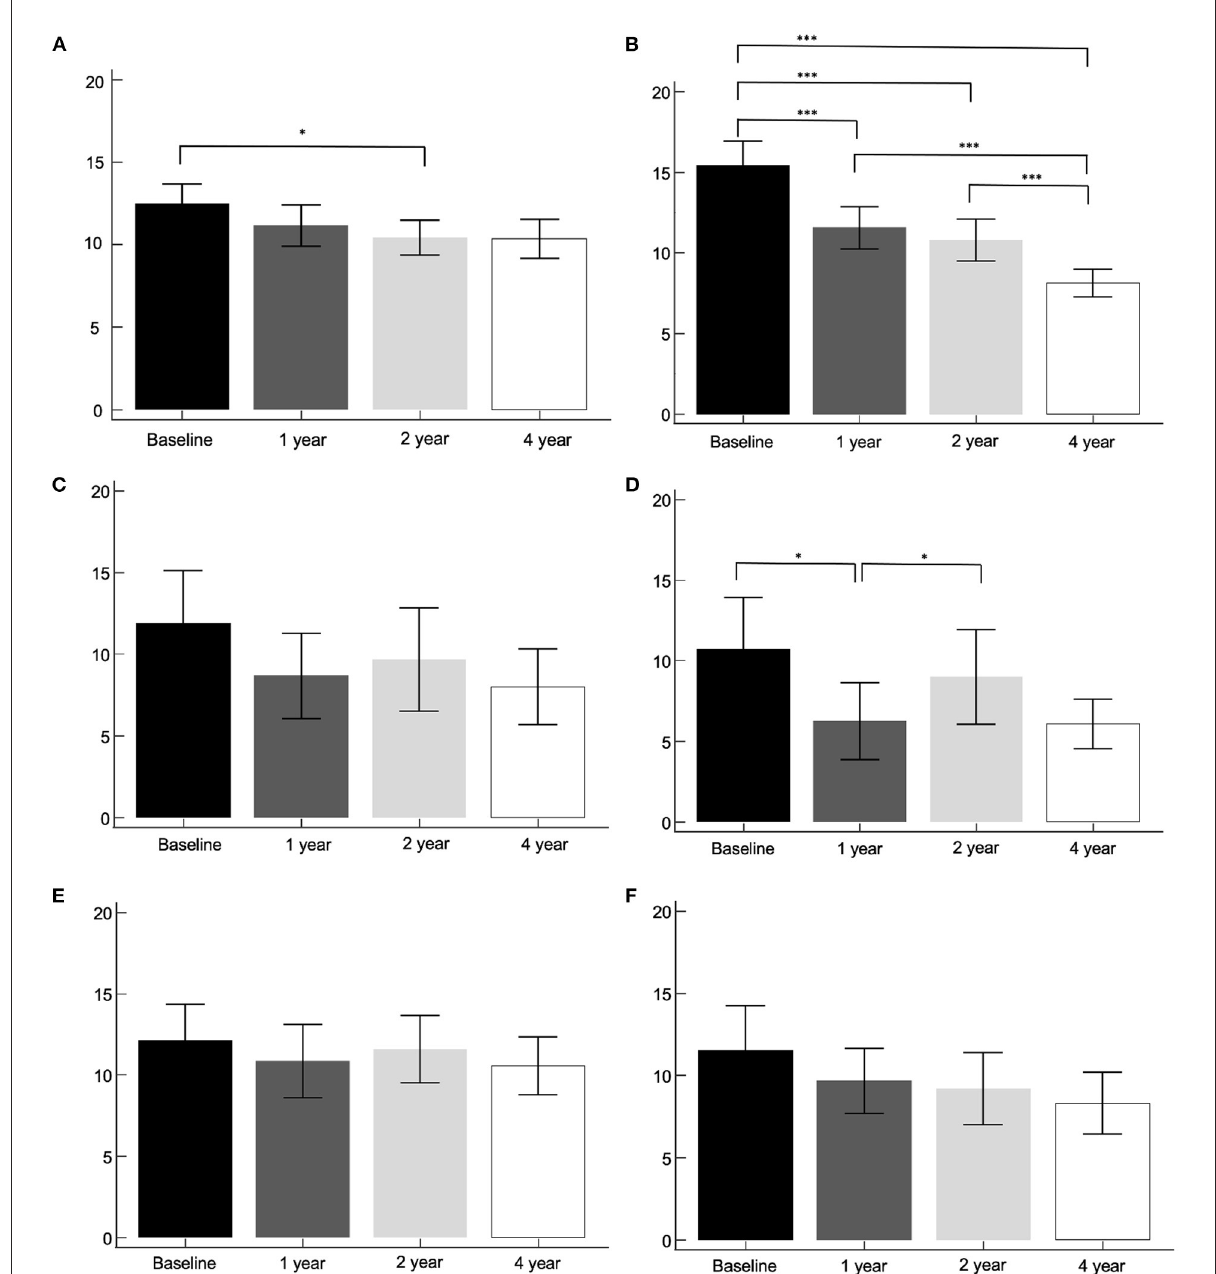
FIGURE3 The asymmetry index by method 2, according to clinical subtypes. Tremor dominant subtype, caudate (A) and putamen (B) . Indeterminant subtype, caudate (C) and putamen (D) . PIGD subtype, caudate (E) and putamen (F) . * p < 0.05, *** p <